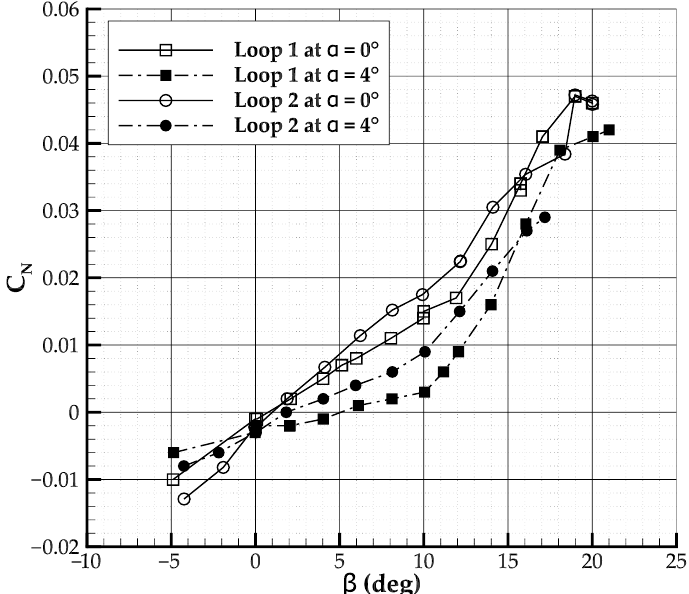
Figure 9. Comparison of the yawing moment coefficient curves for the two design loop. Reference point at x CG = 0, V = 35m/s, Re = 315,000.